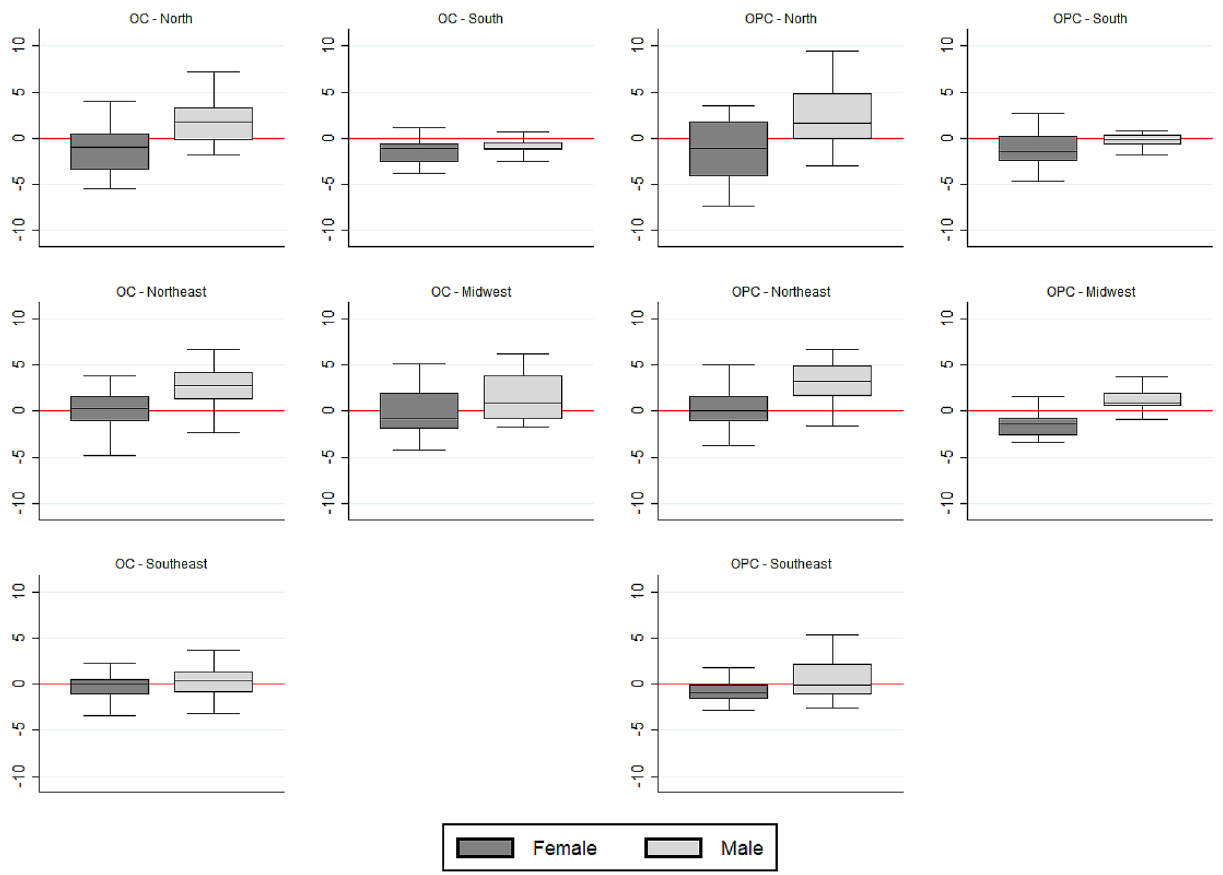
Figure 1. Annual percent change of oral (OC) and oropharyngeal cancer (OPC) mortality: variation across the intermediate geographic regions (IGR), by sex, and macro-region. Brazil,